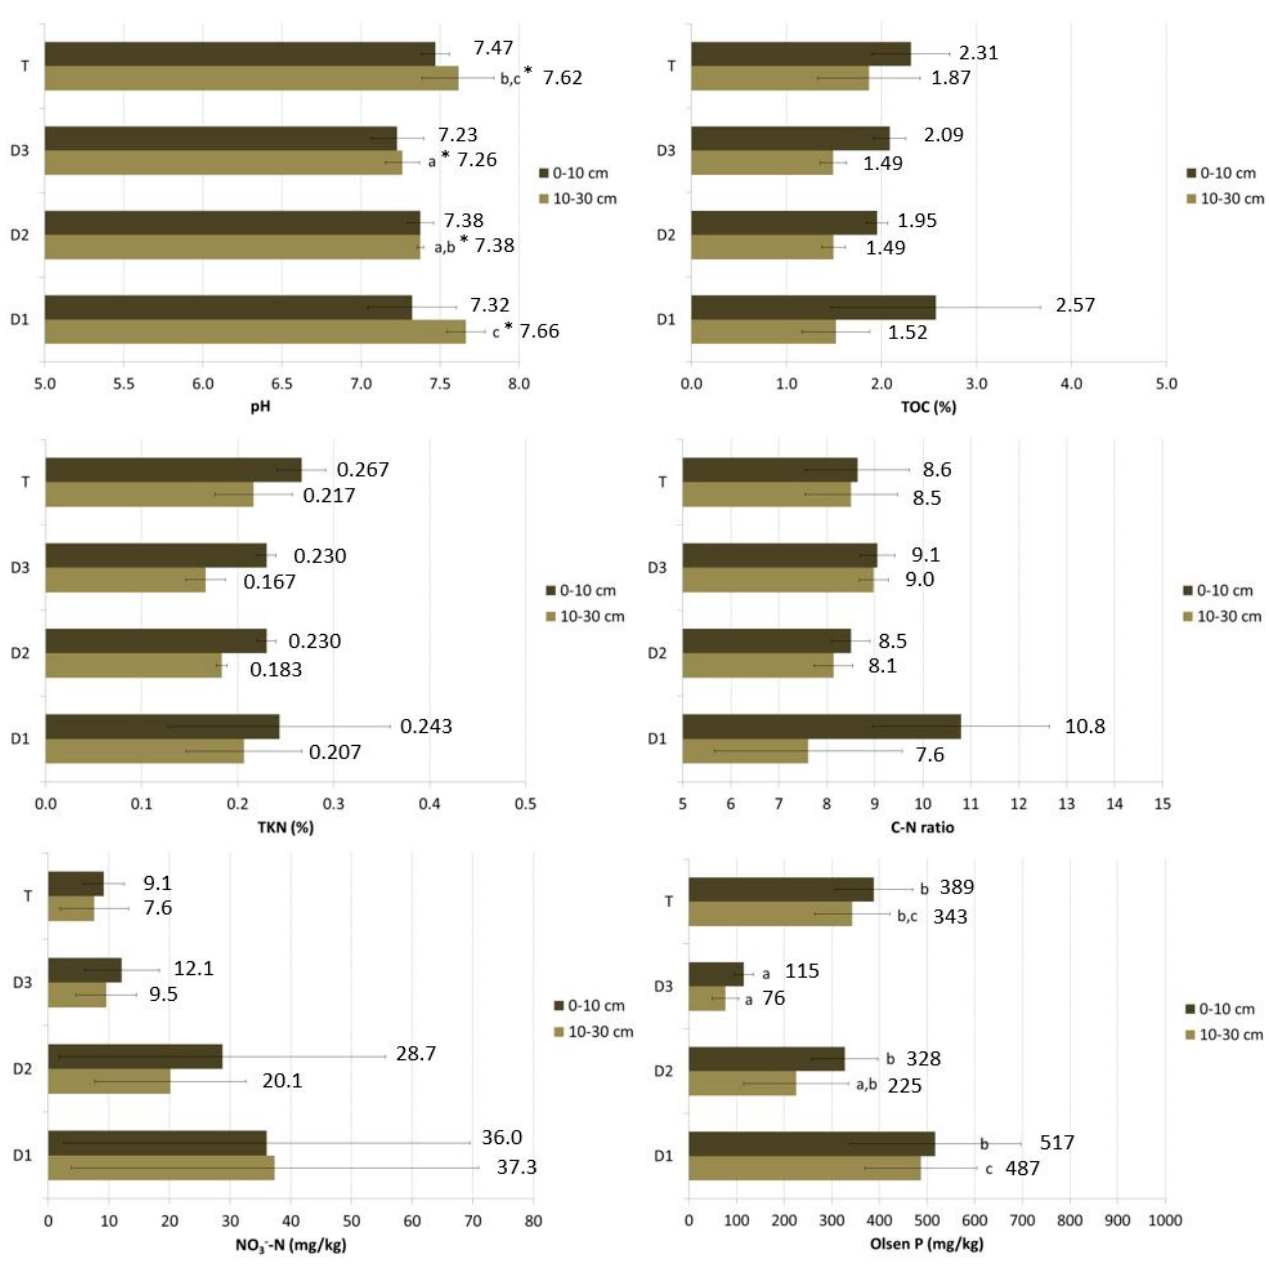
Figure 2. Average values and standard deviation for each sampling position and depth (FB). Different letters correspond to statistically significant differences among the means of measurements of the same depth at different distances. * significant at p ≤ 0.05 according to ANOVA-test.